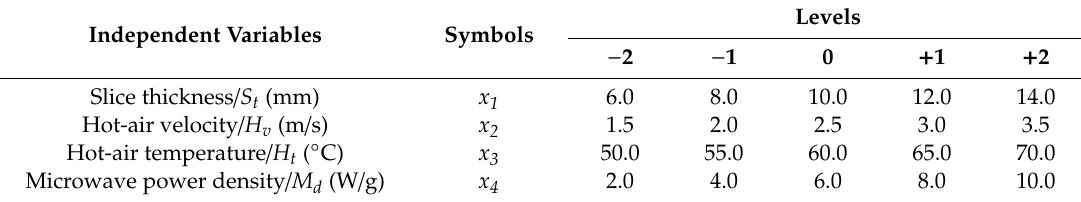
Table 2. The independent variables and levels for the Response surface methodology (RSM) design. Levels Independent Variables Symbols − 2 − 1 0 + 1 + 2 Slice thickness / S t (mm) x 1 6.0 8.0 10.0 12.0 14.0 Hot-air velocity / H v (m / s) x 2 1.5 2.0 2.5 3.0 3.5 Hot-air temperature / H t ( ◦ C) x 3 50.0 55.0 60.0 65.0